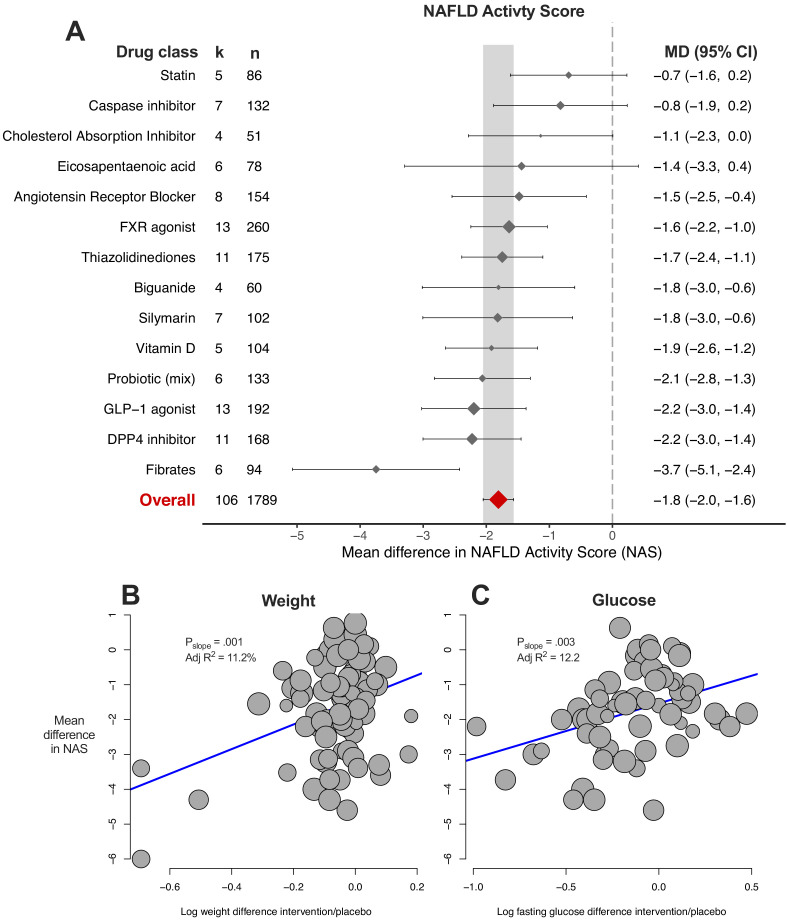
Meta-analysis of NAFLD Activity Score (NAS) in rodent studies of NAFLD.(A) Forest plot with subgrouping by class of drug. Individual studies have been hidden and only subgroup summaries are illustrated. k represents the number of cohorts in each subgroup. The total number of animals is calculated from the sum of control and interventional animals for each subgroup. CI, confidence interval; DPP4, Dipeptidyl peptidase-4; FXR, Farnesoid X receptor; GLP-1, Glucagon-like peptide-1; MD, mean difference. (B) Meta-regression bubble plot using (log) difference in weight between interventional and control animals, after removal of studies using models that induce weight loss. (C) Meta-regression bubble plot using (log) difference in glucose between interventional and control animals, after removal of studies using models that induce weight loss.Figure 7—source data 1.Results of meta-analysis and meta-regression of NAFLD Activity Score (NAS) in rodent studies of NAFLD.Tab 1. Results from meta-analysis of NAS with subgroup by drug class. Tab 2. Results from meta-analysis of NAS with subgroup by individual drug. Tab 3. Results from meta-analysis of NAS with subgroup by drug class, after removal of outlier studies. Tab 4. Results from univariable meta-regression analyses. Tab 5. Results from model 1 (without drug) and model 2 (including drug used) multivariable meta-regression analyses.